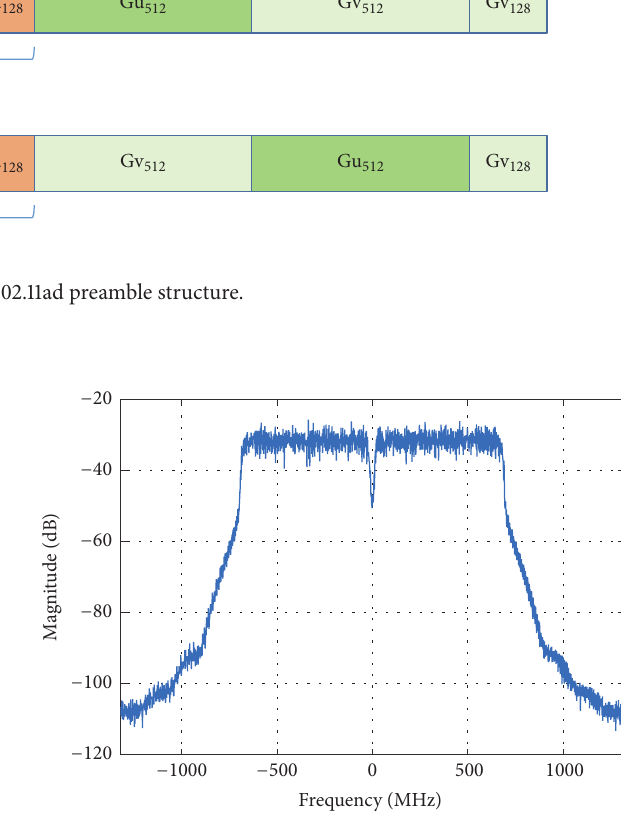
Figure 6: GFDM spectrum with DC nulling ( 𝐾 = 8,𝑀 = 64 ). Figure 7: GFDM spectrum with DC nulling and frequency shift ( 𝐾 = 8,𝑀 = 64